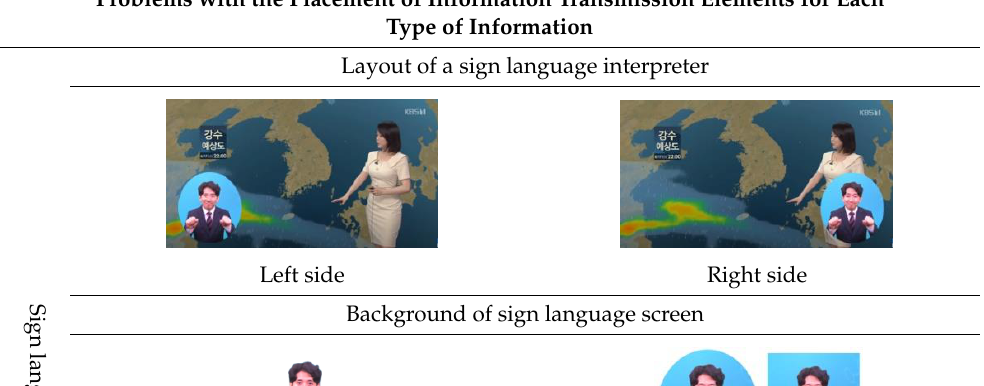
Table 1. Elements of information delivery to be considered in TV broadcasting for DHH individuals. Problems with the Placement of Information Transmission Elements for Each Type of Information